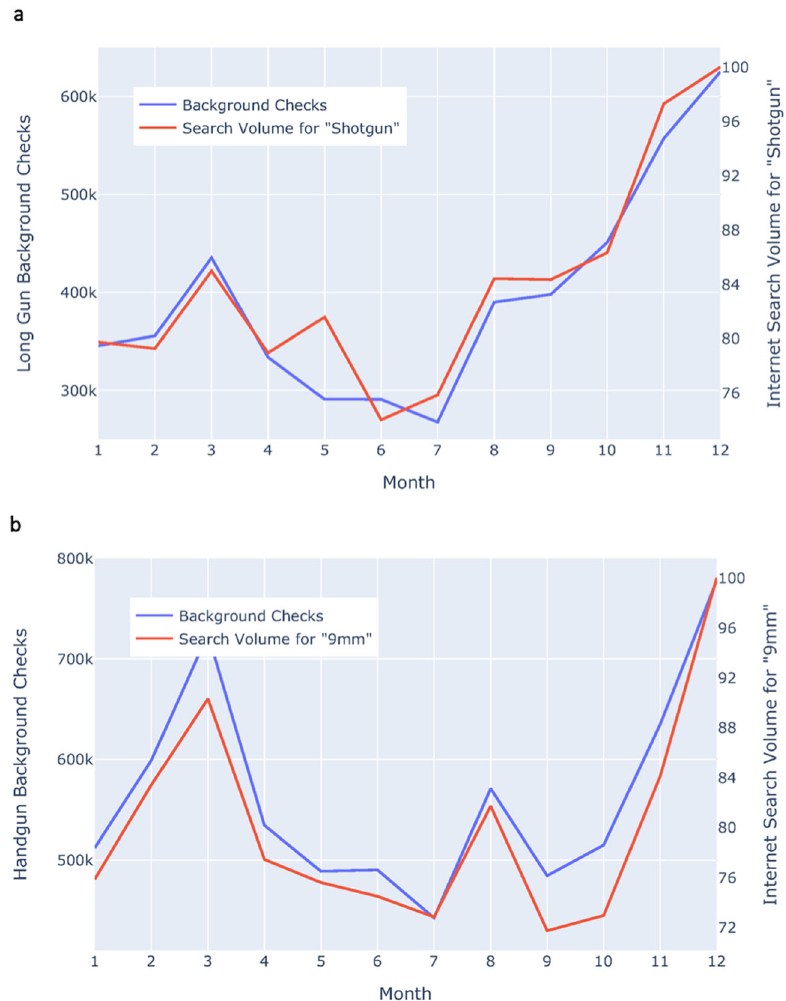
Fig. 1 Monthly comparison of background checks vs. search volumes. a U.S. long-gun background checks vs. U.S. relative Internet search volume for the term shotgun (Pearson ’ s r = 0.96, Spearman ’ s ρ = 0.94) and b U.S. handgun background checks vs. U.S. relative Internet search volume for the term 9 mm in 2019 (Pearson ’ s r = 0.97, Spearman ’ s ρ =